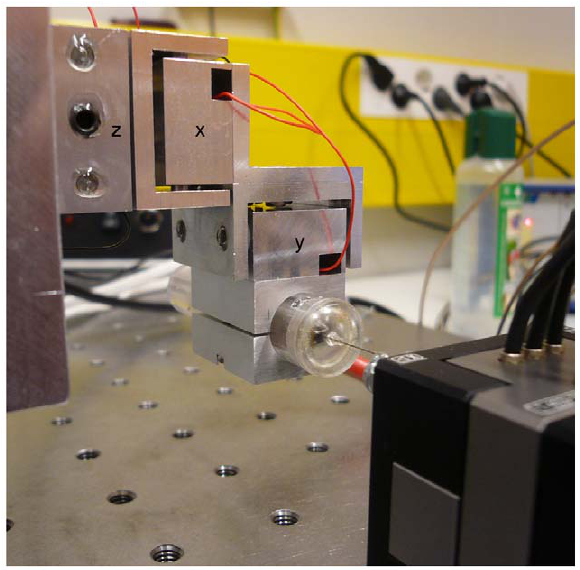
Figure 6. Photograph of the 3D stabilization system prototype. The three-axis actuator is mounted sideways to a vertical platform and the 3D movement sensor is attached to the last actuator of the assembly; the probe tip is glued to the commercial nanopositioning system at the bottom right corner Axis definitions are placed to each of the actuator axis to enable comparison to schematic presentation in Figure 1E.